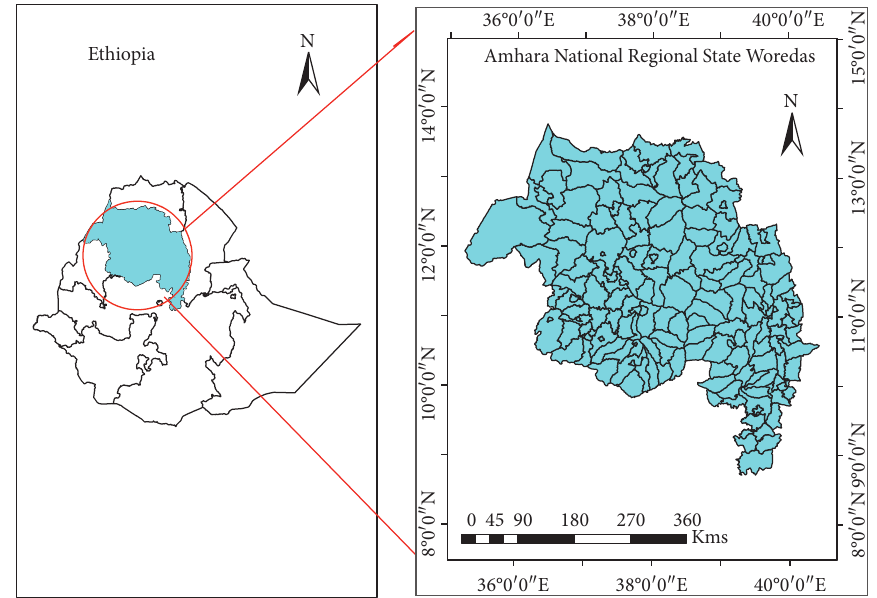
Figure 1: Study area map showing districts in the Amhara national regional state, Ethiopia in